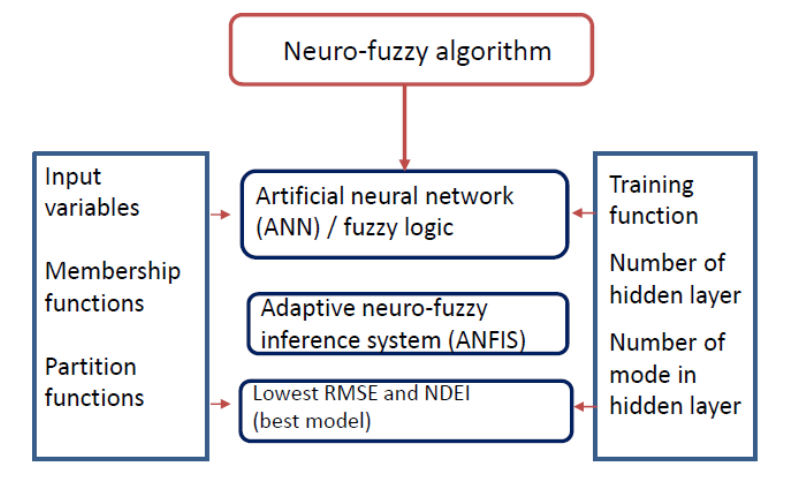
Figure 1. Categorisation of the neuro-fuzzy (NF) technique showing combined artificial neutral network (ANN) and fuzzy-logic (FL) underpinned by adaptive NF inference system (ANFIS).